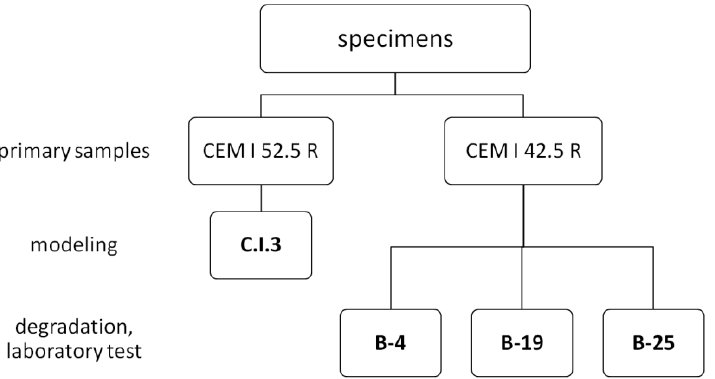
Figure 1. Specification of tested samples.